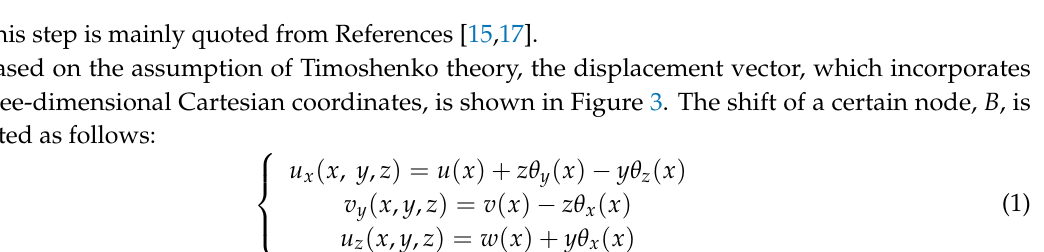
Figure 3. Beam geometry and kinematic variables.